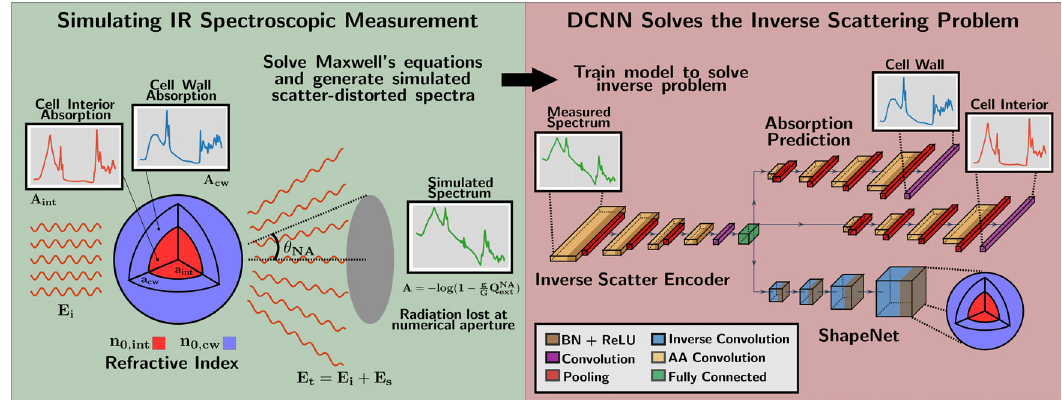
Fig. 1 The approach for training the ISP-solver on simulated spectral data. Illustration of the proposed approach where we fi rst solve the forward problem by exact simulation and then train a DCCN to solve the inverse problem. We start by solving Maxwell ’ s equations for light propagating through the sample and thereby simulating the spectroscopic measurement. We assume a two-layered concentrically spherical sample, with distinct molecular absorption and effective refractive index in the cell wall and interior. Radiation which scatters into the numerical aperture, characterized by its angle θ NA , is collected at the detector and contributes to the measured spectrum. These simulated spectral data are then used as training data for our DCCN, which is trained to solve the inverse scattering problem. The model is a DCNN consisting of a 1D attention-augmented CNN (InverseScatterEncoder) which decomposes the measured spectra, two 1D attention-augmented CNN with unpooling layers which infer the molecular absorption spectra of the cell wall and cell interior and a 3D transpose-CNN (ShapeNet) inferring the optical and morphological properties of the sample.